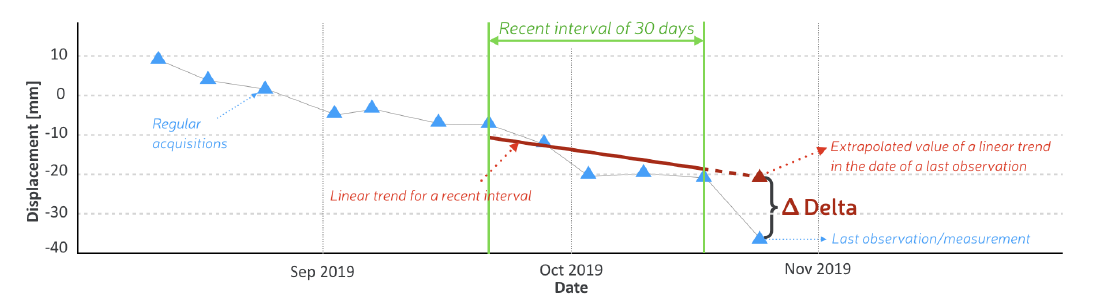
Figure 7. Schematic illustration of time series warning. A similar approach can be found in